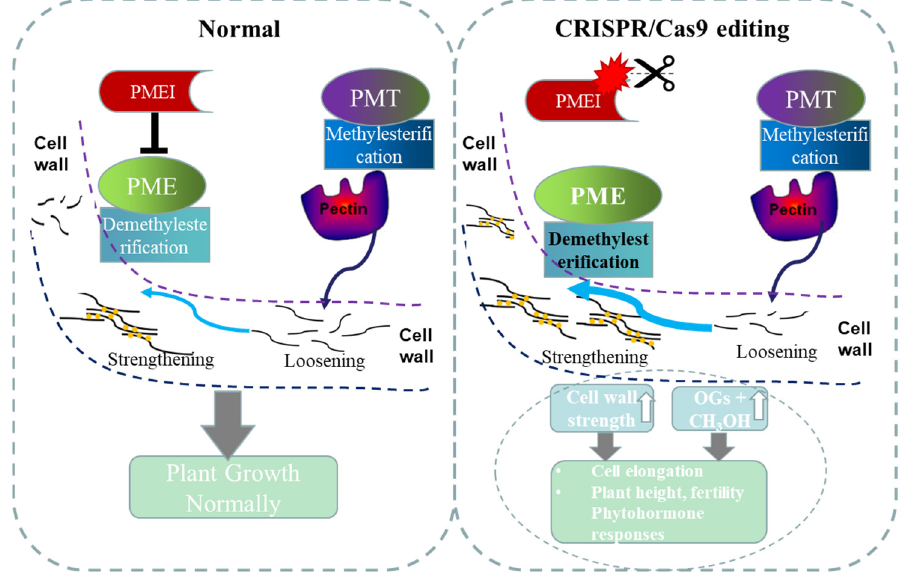
Figure 9. A model was proposed to elucidate that perturbation of OsPMEI and OsPME interaction results in the increased demethylesterification of pectin and has broader effects on cell wall features, plant growth, and phytohormone responses. PMEI: pectin methylesterase inhibitor; PME: pectin methylesterase; PMT: pectin methyltransferases.